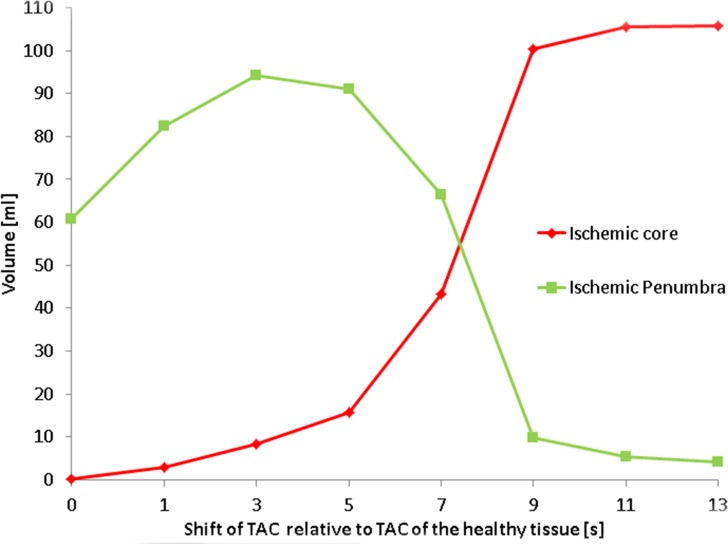
Ischemic core and penumbra from phantom data.This figure shows the effect of shifting TACs of the hypoperfused tissue relative to the TACs of the healthy tissue, and thus simulating contrast arrival delay, on ischemic core and penumbra determination.